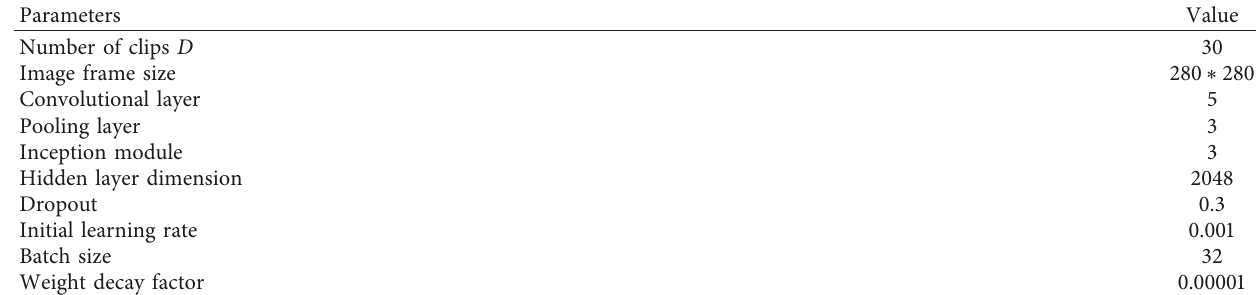
Table 1: Experimental parameter settings.